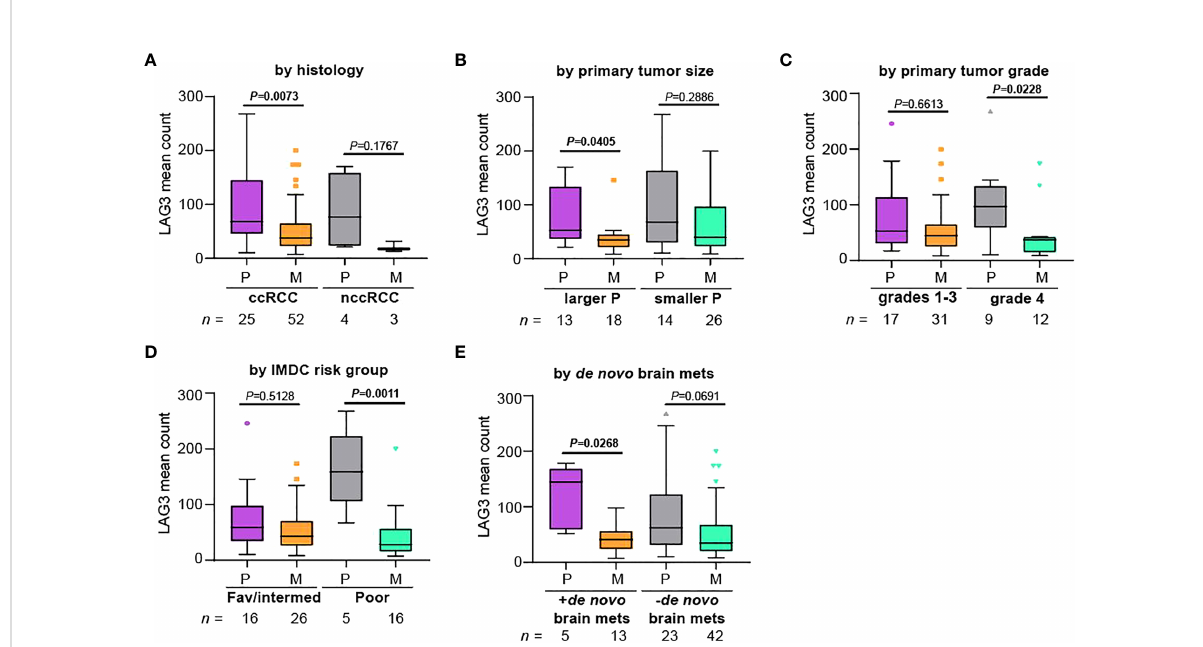
FIGURE 3 Differences in LAG3 expression between primary and metastatic tumors are more pronounced in patients with certain high-risk features. Patients were divided based on (A) histology, (B) primary tumor size, (C) primary tumor grade, (D) IMDC risk group, and (E) whether the patient had de novo brain metastases, and normalized mean LAG3 counts were compared between primary tumors ( “ P ” ) and metastases ( “ M ” ) within each group. We note that this cohort was enriched for patients with brain metastases. For (B) , patients were segmented based on the median primary tumor size. The Kruskal-Wallis test was performed comparing primary tumors to metastases. All graphs represent Tukey plots. ccRCC, clear cell RCC; nccRCC, non-clear cell RCC; IMDC, International Metastatic RCC Database Consortium; Fav/intermed, favorable/intermediate; brain mets, brain